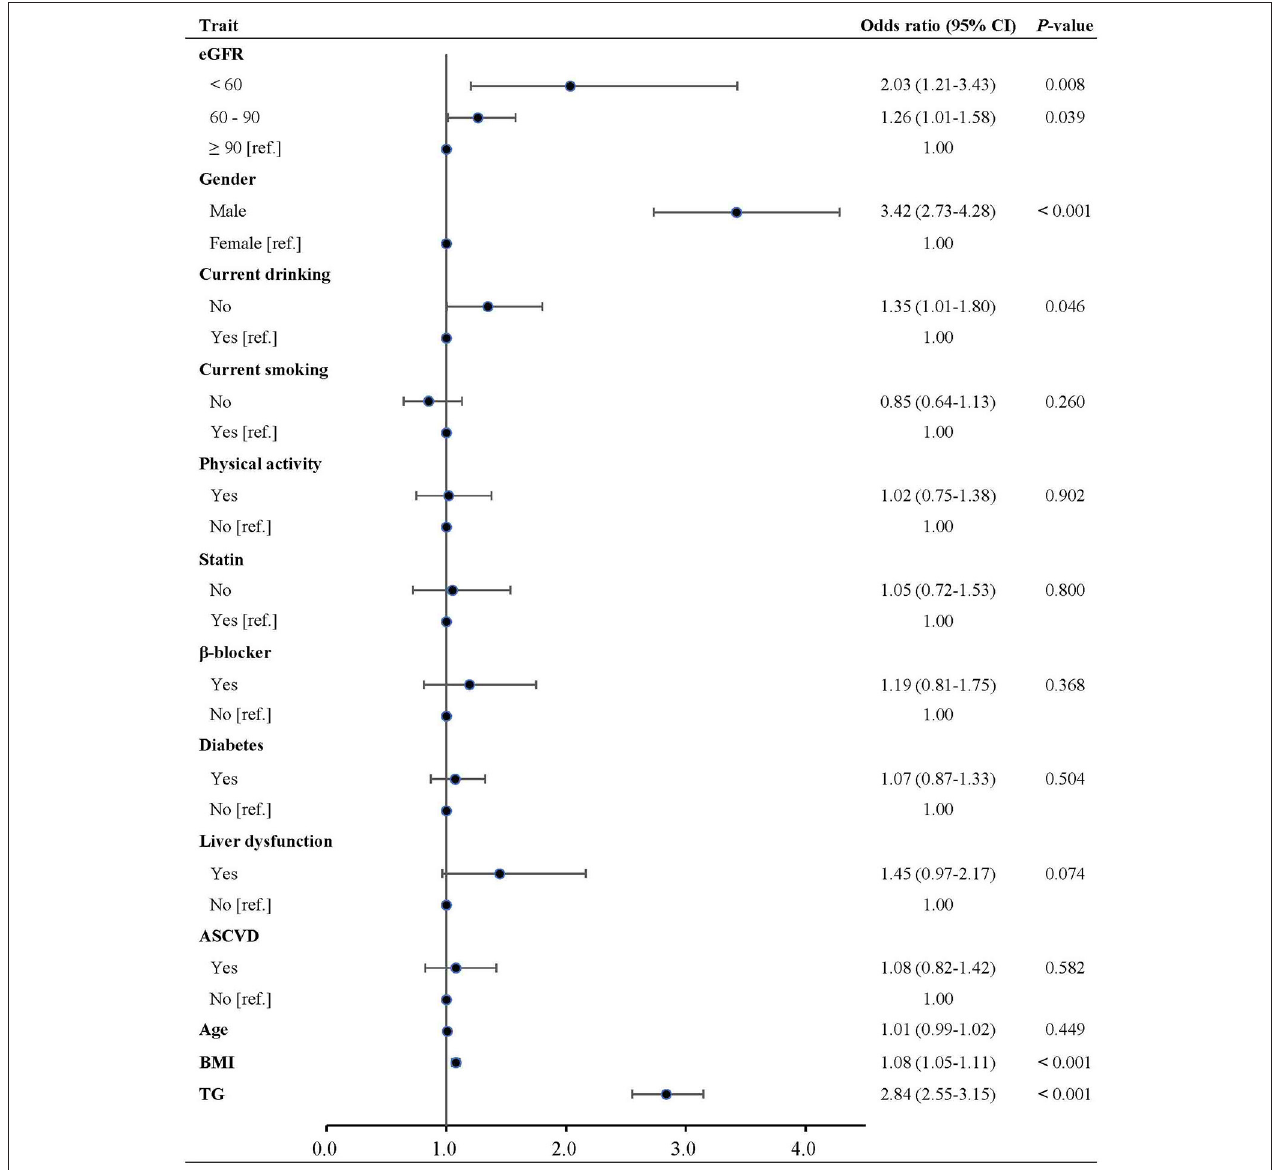
FIGURE 2 | Multivariable-adjusted odds ratios of low HDL-C in participant subgroups. HDL-C, high-density lipoprotein cholesterol; eGFR, estimated glomerular filtration rate; BMI, body mass index; ASCVD, atherosclerotic cardiovascular disease; TG,